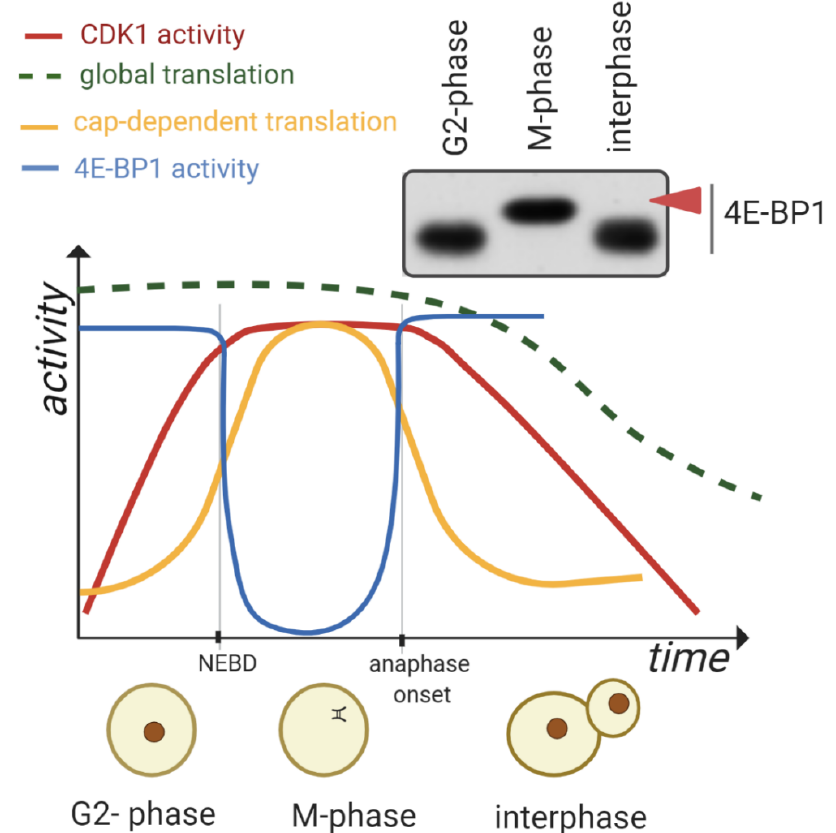
Figure 1. Dynamics of cyclin dependent kinase 1 (CDK1) activity, global translation and inactivation of the translational repressor 4E-BP1 with consequent stimulation of cap-dependent translation during the M-phase. At the beginning of the M-phase, the intensity of global translation is at high levels and CDK1 activity sharply increases accompanied by nuclear envelope breakdown (NEBD). CDK1 activity peaks during assembly of the spindle and 4E-BP1 becomes exclusively hyperphosphorylated (red arrowhead) which results in its inactivation as a translational repressor. At the exit of the M-phase, CDK1activitydropsalongsidetheincreasedactivityofthecap-dependenttranslationalrepressor4E-BP1. The intensity of global translation decreases during the time course of the M-phase. Immunoblot image using pan 4E-BP1 antibody shows an exclusive phosphorylation shift in the M-phase of the mouse oocyte (red arrowhead)